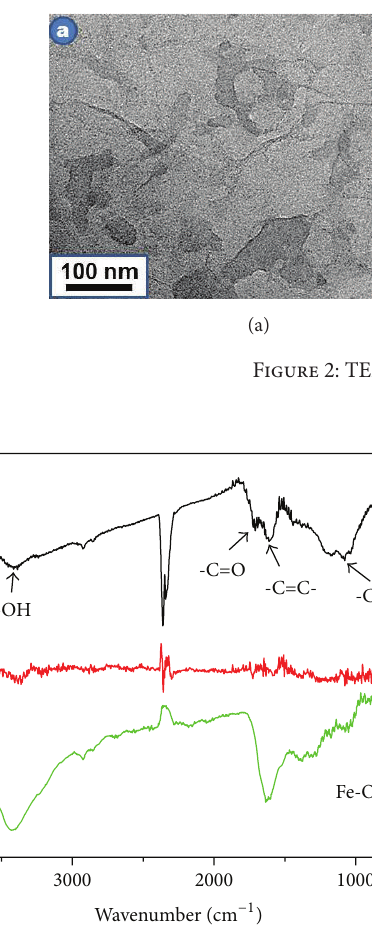
respectively. The band around 578 cm −1 was attributed to Fe- O, replying the existence of Fe 3 O 4